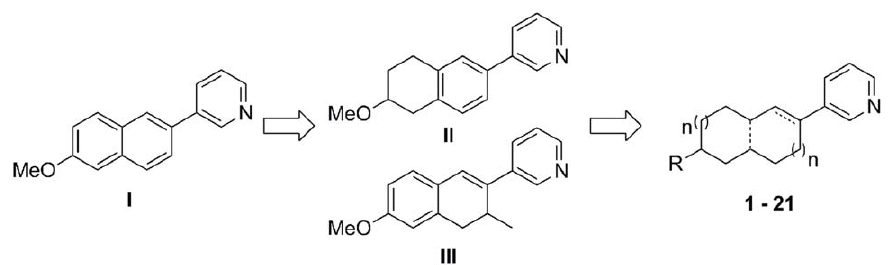
Figure 3. Conception of inhibitors design.